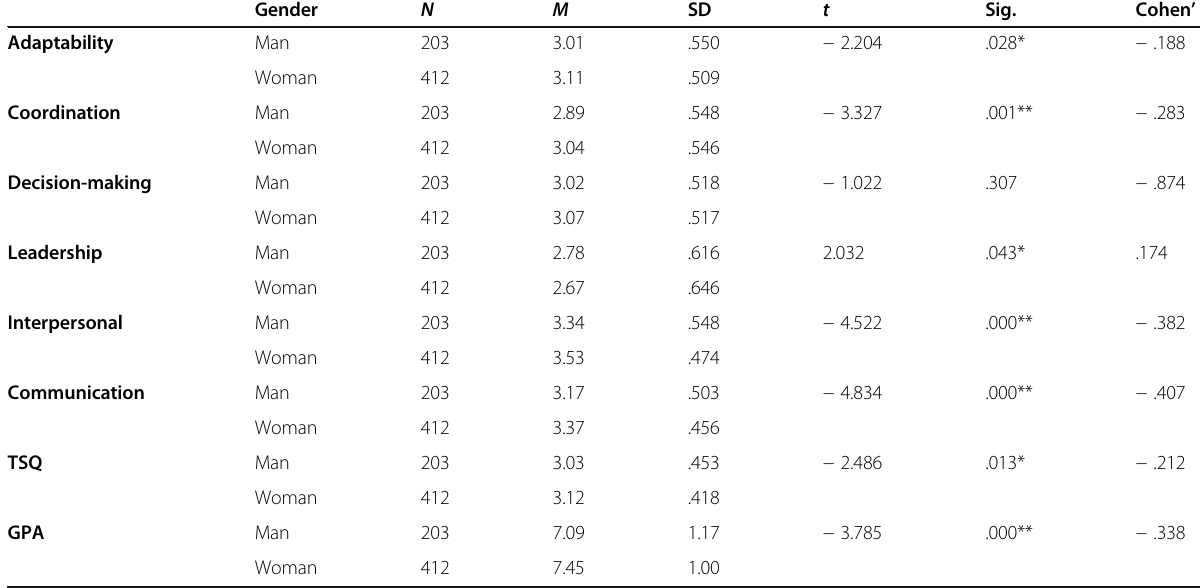
Table 3 T -student results based on gender for each of the factors, TSQ and GPA Gender N M SD t Sig. Cohen ’ d Adaptability